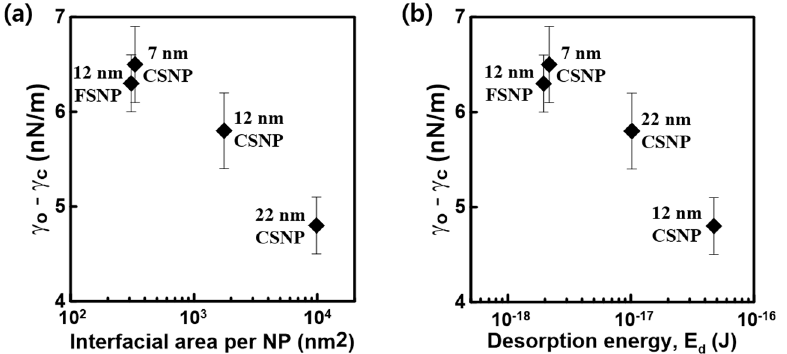
Figure 6. ( a ) IFT reduction as function of the interfacial area covered per NP and ( b ) the desorption energy required to remove one NP. energy required to remove one